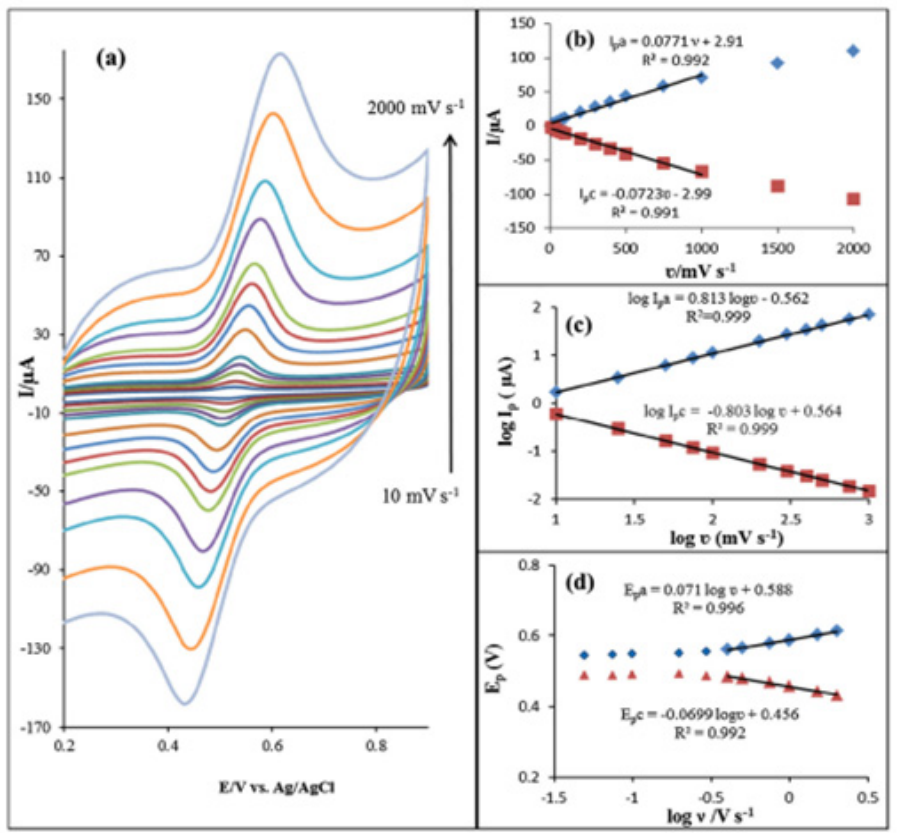
Figure 8. ( a ) CV responses of the modified electrode in Britton–Robinson buffer solution (pH 2) at scan rates (inner to outer) 10, 25, 50, 75, 100, 150, 200, 300, 400, 500, 750, 1000, 1500 and 2000 mV·s − 1 . ( b ) The plot of anodic and cathodic peak current vs. scan rate. ( c ) The plot of anodic and cathodic peak current vs. logarithm of scan rate and ( d ) the variation of anodic and cathodic potential vs. logarithm of scan rate. Published from [62] with the permission of the publisher. The relative standard deviation of five successive measurements with the same electrode toward 1 × 10 − 6 mol·L − 1 CGA was approximately 3%, suggesting good repeatability of the studied sensor. The long-term stability of the modified electrode was also verified, the current intensities following the measurements made for 1 × 10 − 6 mol·L − 1 CGA remaining at 95% of its initial value after a month of storage at room temperature. The applicability of the sensor studied was evaluated by determining the CGA content in two plant extracts. The results obtained were satisfactory, with analytic recovery in the 98.6–105.8% range, which indicates that the proposed sensor could be efficiently applied in reliably determining CGA from plant extracts [62]. Another study was aimed to prepare the TAPB-DMTP-COFs composite doped with gold